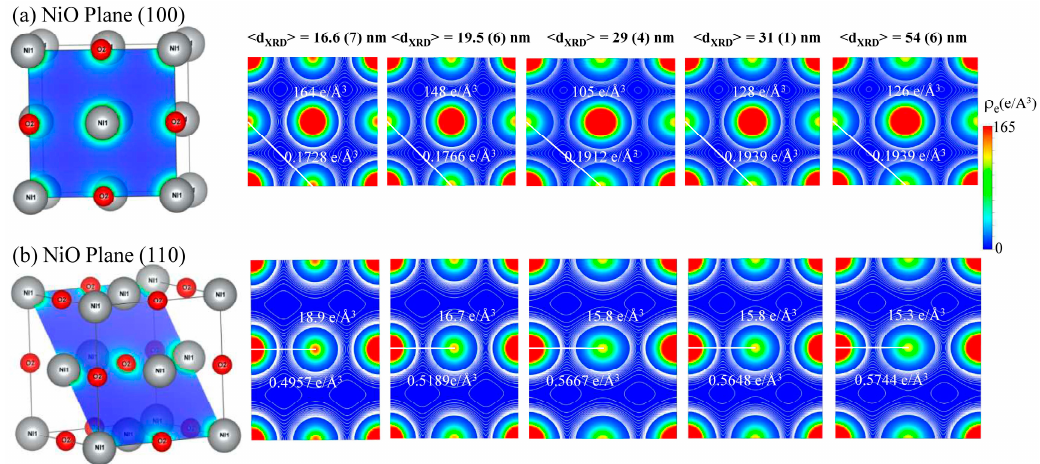
Figure 1. Two-dimensional electron density maps drawn ( a ) parallel to (100) and ( b ) (110) crystallographic planes of NiO nanoparticles with size ranging from 16.6 ± 0.7 to 54 ± 6 nm (left to right), respectively.